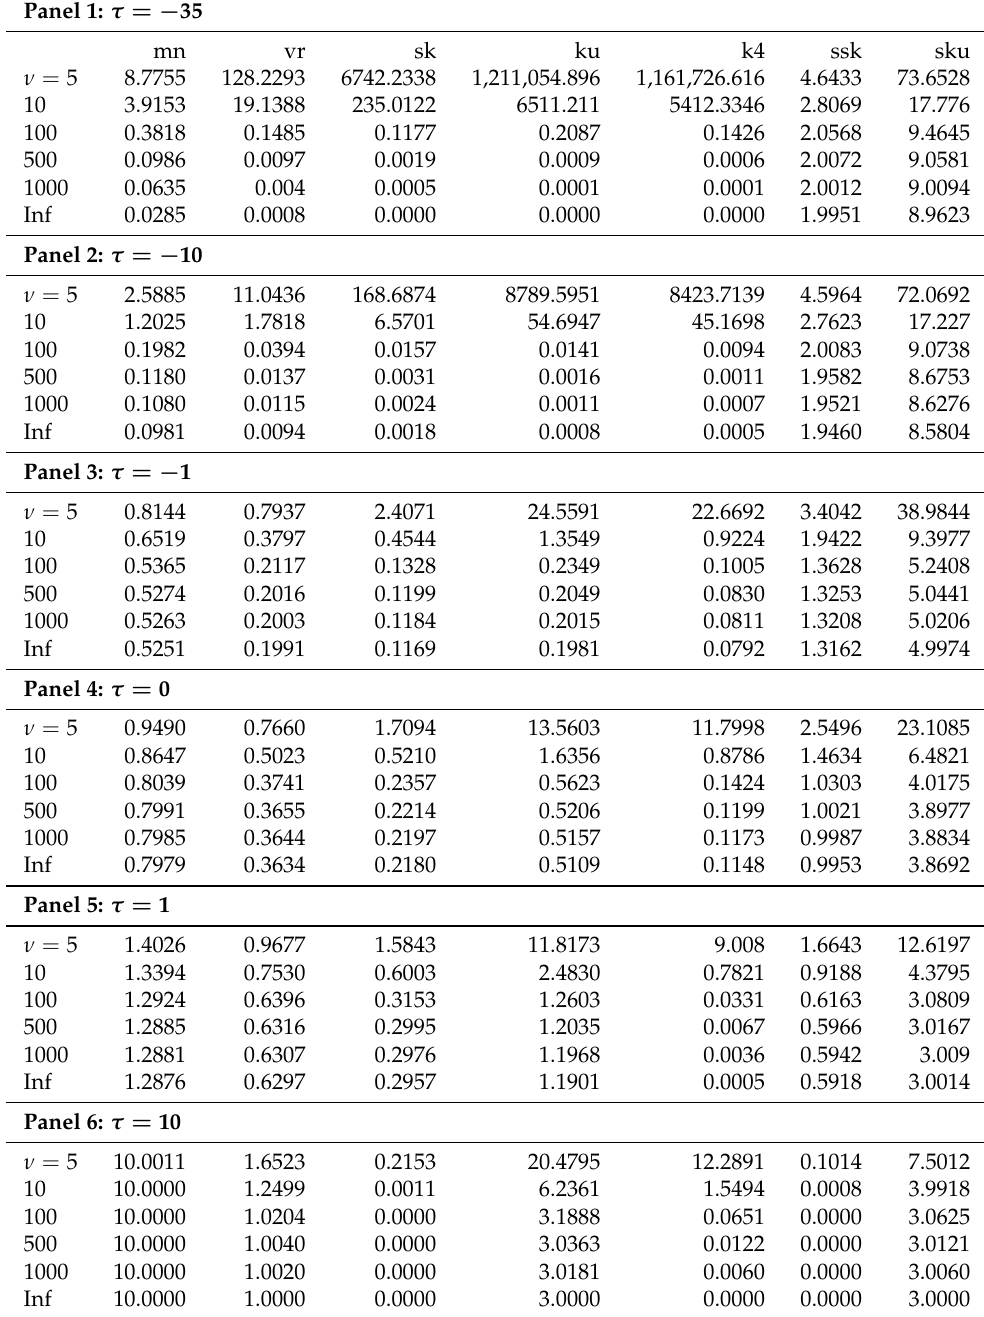
Table 5. Moments of the Truncated Student’s t